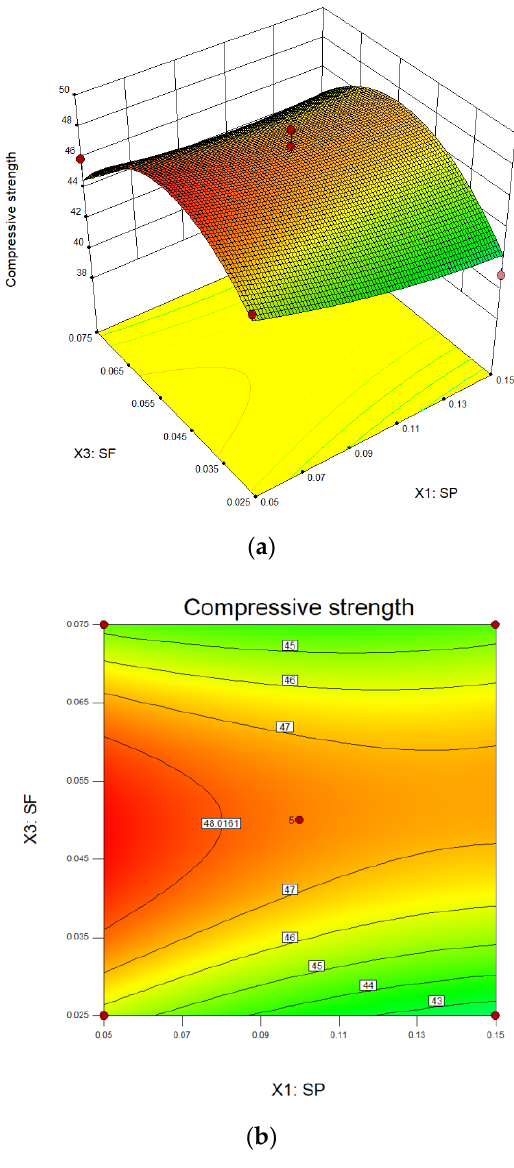
Figure 7. Response surface and contour in SP-SF. ( a ) Response surface. ( b ) Contour.